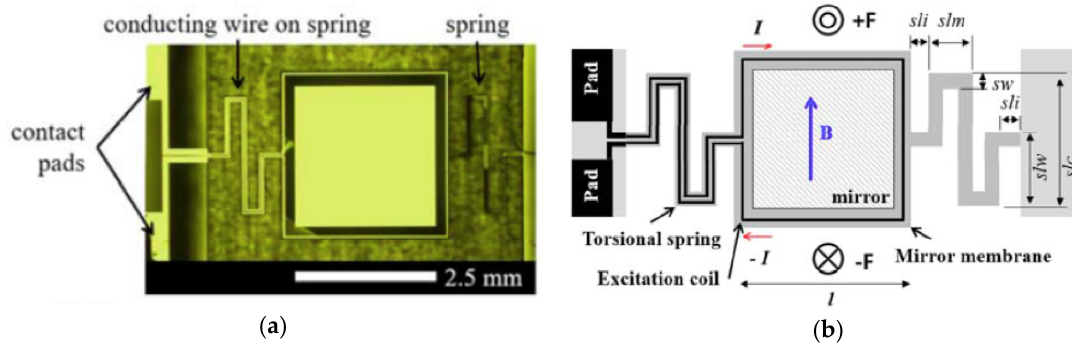
Figure 21. ( a ) Microscope image of a MEMS magnetic field sensor with optical readout; and ( b ) operation principle of the sensor [34]. Reprinted with permission from [34]. Copyright© 2016, Elsevier B.V.